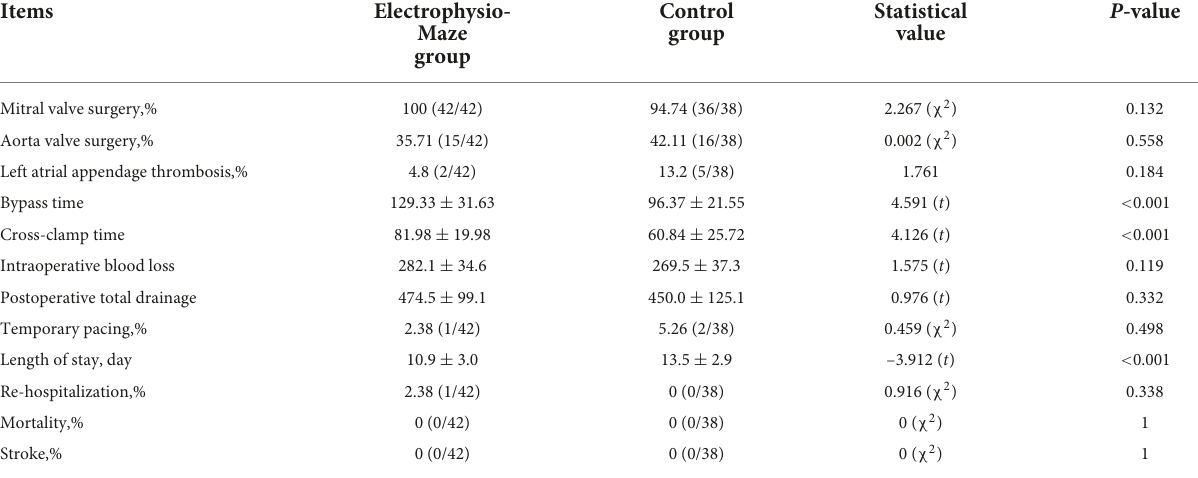
TABLE 2 Comparison of perioperative characteristics between two